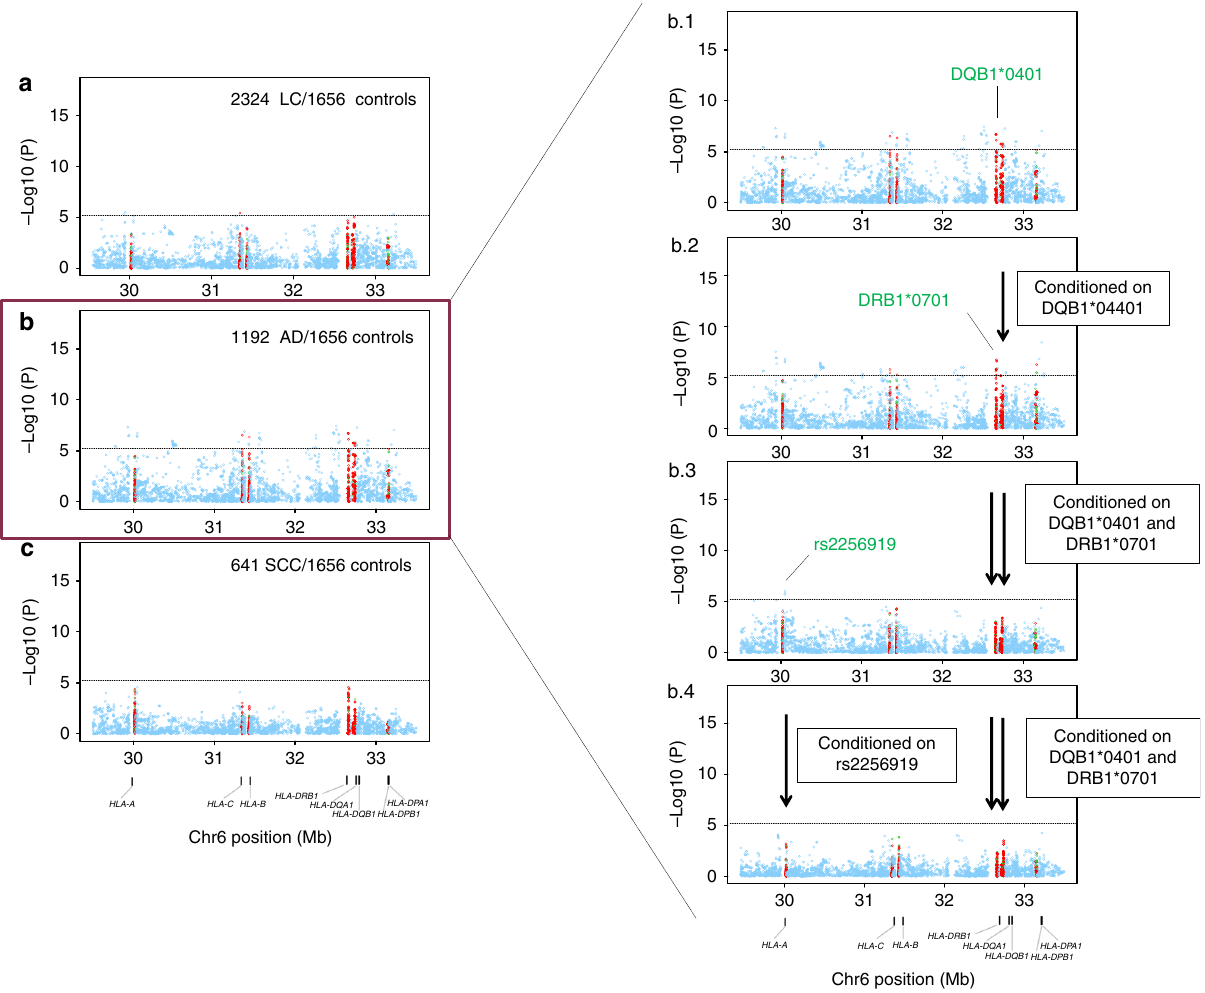
Fig. 2 Asian regional association plots of variants in the MHC region and lung cancer overall and major histologies ( a – c ); plots of stepwise conditional analyses for lung adenocarcinoma (b. 1 – b. 4). Each panel on the left shows the association plot for each analysis a lung cancer overall, b adenocarcinoma, c squamous cell carcinoma. The association for each locus used for conditioning is shown in green in each panel on the right (b. 1) unconditioned, (b. 2) conditioned on HLA-DQB1*0401 , (b. 3) conditioned on HLA-DQB1*0401 and HLA-DRB1*0701 , (b. 4) conditioned on HLA-DQB1*0401, HLA-DRB1*0701 and rs2256919 (SNP within HLA-A ). Detailed association results in Table 3 and Supplementary Figure 1. Circles represent – log10 ( P values) for each binary marker using the imputed allelic dosage (between 0 and 2). The dashed black horizontal lines represent the study-wide signi fi cant threshold of P = 6 × 10 − 6 . The physical positions of HLA genes on chromosome 6 are shown at the bottom. The color of the circles indicates the type of marker; light blue — SNPs, green — classical HLA alleles, and red — amino acid polymorphisms of the HLA